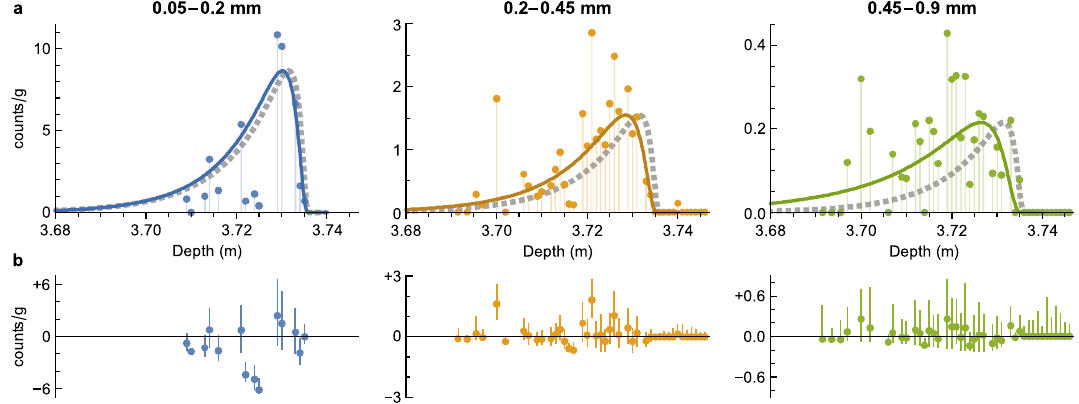
Figure 4. Microtektite distribution fits. ( a ) Concentration of three microtektite size classes in core MD90-0961 (dots), and Poisson fit with Eq. (2) (solid lines). The dashed lines represent the impulse response (rescaled to the same maximum value of the fits) for sediment particles of average size, as predicted by the same model. Notice the offset of large microtektites with respect to the impulse response. ( b ) Model residuals corresponding to